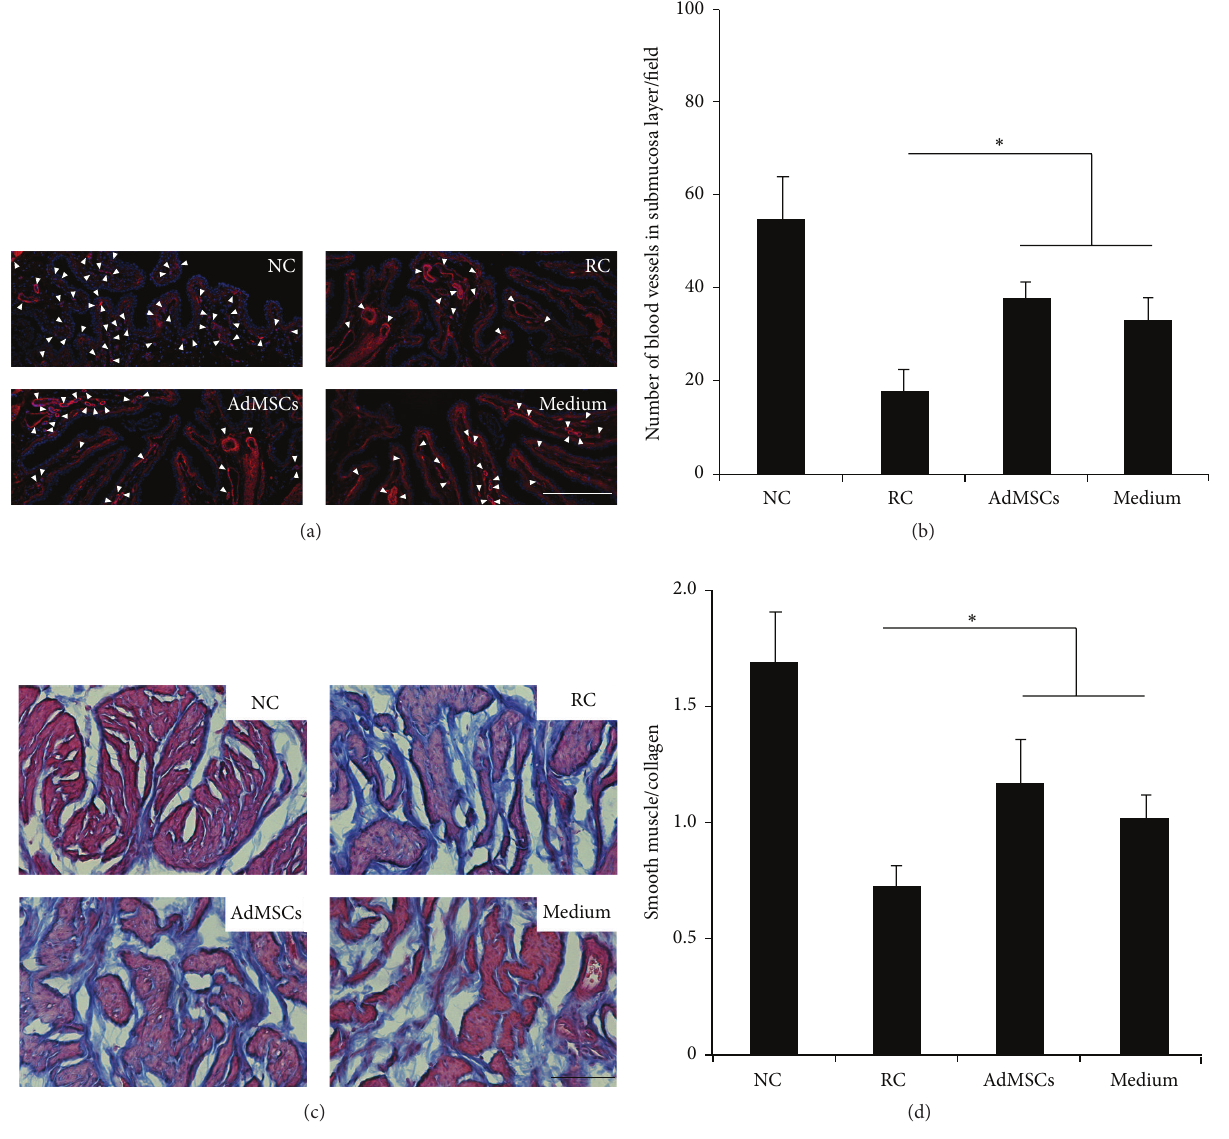
Figure 4: Histological analysis of bladder tissue. (a) Representative images of blood vessels in the submucosa layer. The white arrows indicate blood vessels while the white bar indicates 200 𝜇 m. (b) Results of the number of blood vessels in the submucosa layer of each experimental group. ∗ 𝑃 < 0.05 compared with RC group. There is no significant difference between AdMSCs group and Medium group. (c) Representative images of Masson’s trichrome staining from each group. The black bar indicates 50 𝜇 m. (d) Results of the ratio between smooth muscle and collagen within the bladder wall of each experimental group. ∗ 𝑃 < 0.05 compared with RC group. There is no significant difference between AdMSCs group and Medium